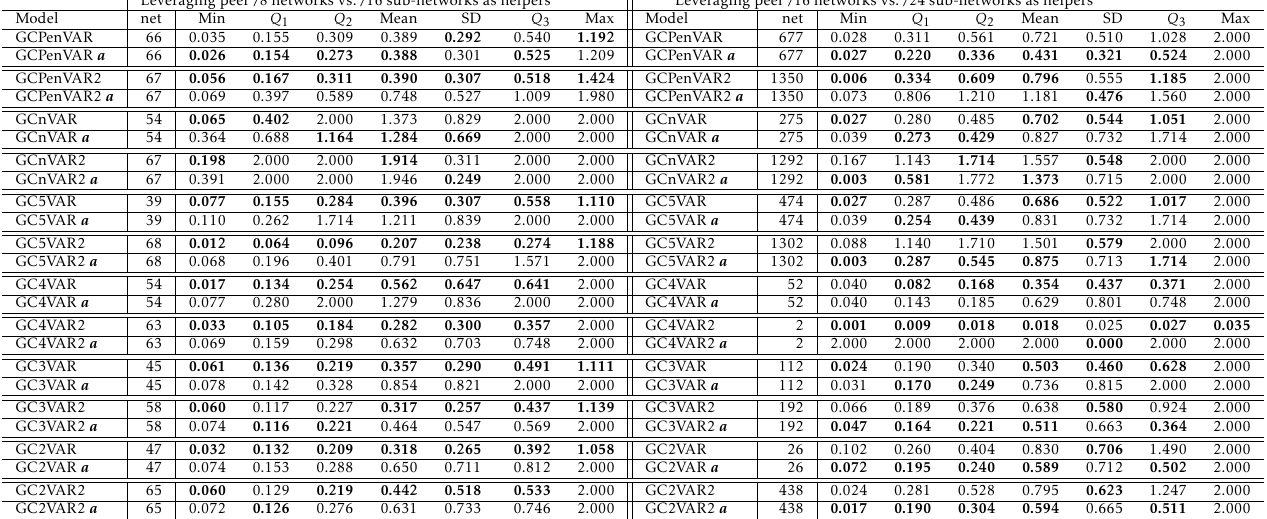
Table 6. Summary statistics of SMAPE values of leveraging peer networks vs. sub-networks as helpers, where a indicates models leveraging sub-networks (i.e., time series data across multiple network resolutions), and bold-font highlights the more accurate prediction when comparing the prediction leveraging time series across network resolutions (i.e., leveraging sub-networks) and the prediction leveraging time series at a single network resolution (leveraging peer networks). Leveraging peer / 8 networks vs. / 16 sub-networks as helpers Leveraging peer / 16 networks vs. / 24 sub-networks as helpers